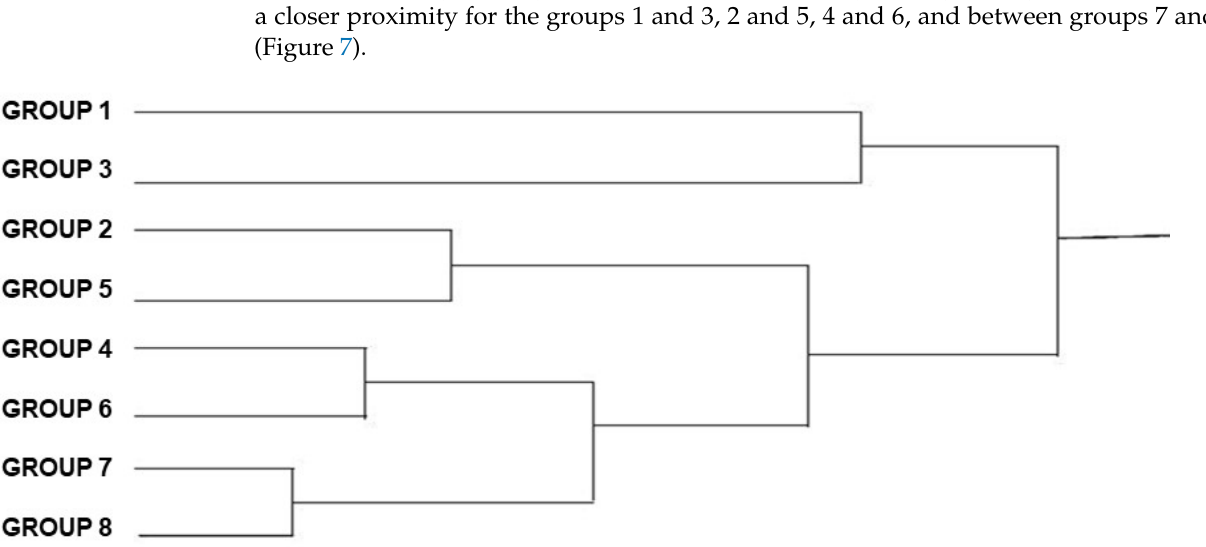
Figure 6. Canonical variate analysis showing the conformation influence in males and females of Triatoma brasiliensis brasiliensis from different states and years (1912–2014). among the groups Canon represents the canonical variate dimension.